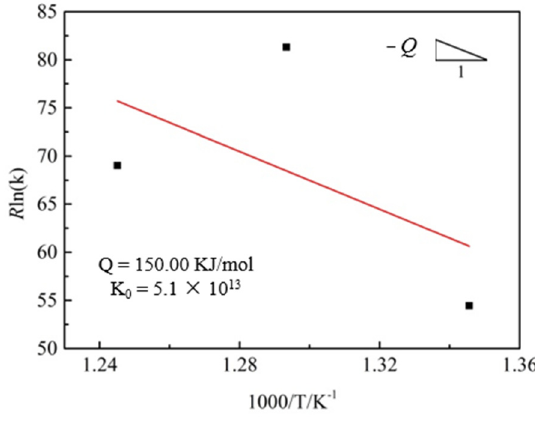
Figure 9. Relationship of R ln(k) vs.1/ T .